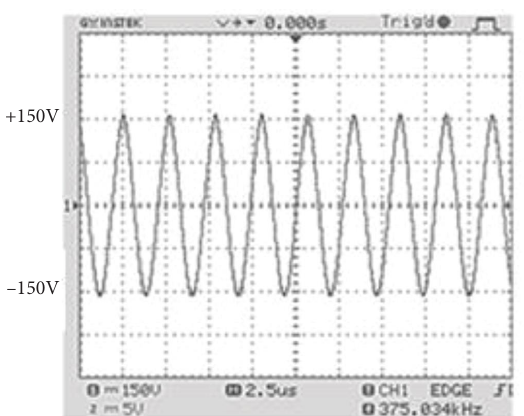
Figure 19: Experimental setup.